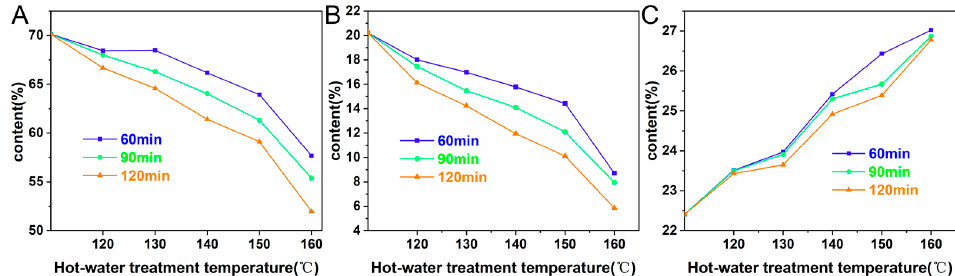
Figure 2. FTIR spectra for bamboo samples.